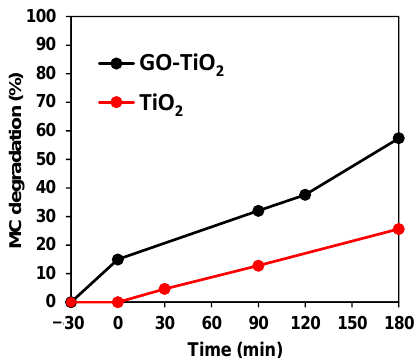
Figure 6. MC photodegradation (20 mg/L) at the catalyst concentration of 800 mg/L with TiO 2 and GO-TiO 2 under simulated solar radiation.